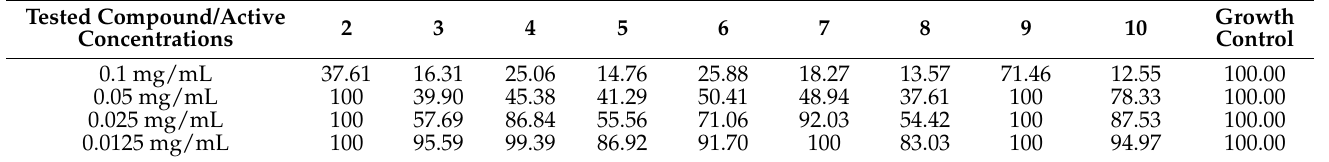
Table 4. Rates of HeLa cell growth expressed as % of control cell